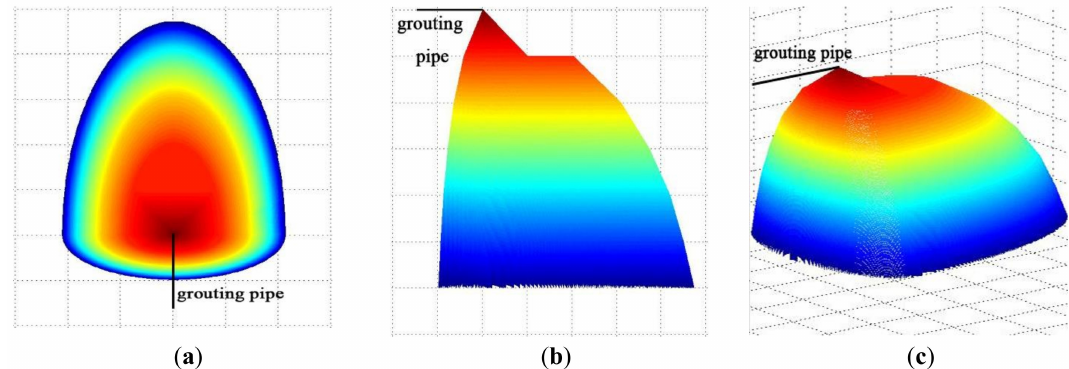
Figure 7. Grout diffusion pattern: ( a ) Top view; ( b ) Side view; and ( c ) Three-dimensional diagram.